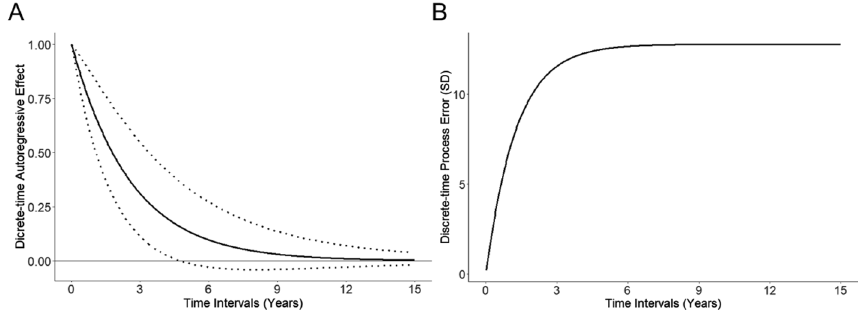
Fig. 5 Discrete-time autoregression ( A ) and Error standard deviation ( B ) as Functions of Underlying Continuous-Time Parameters and the Length of Time-Intervals Between Measurement Occasions. Dotted lines represent the 95% confidence interval of the discrete-time autoregressive effects corresponding to Table 4 column